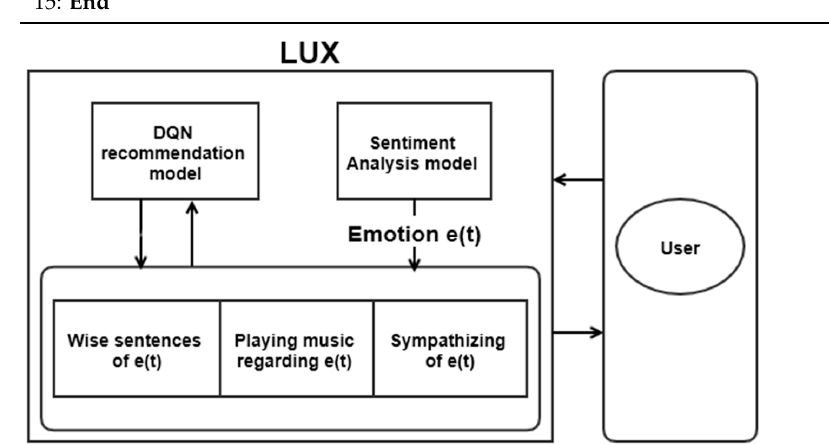
Figure 4. DQN algorithm for recommending user response.